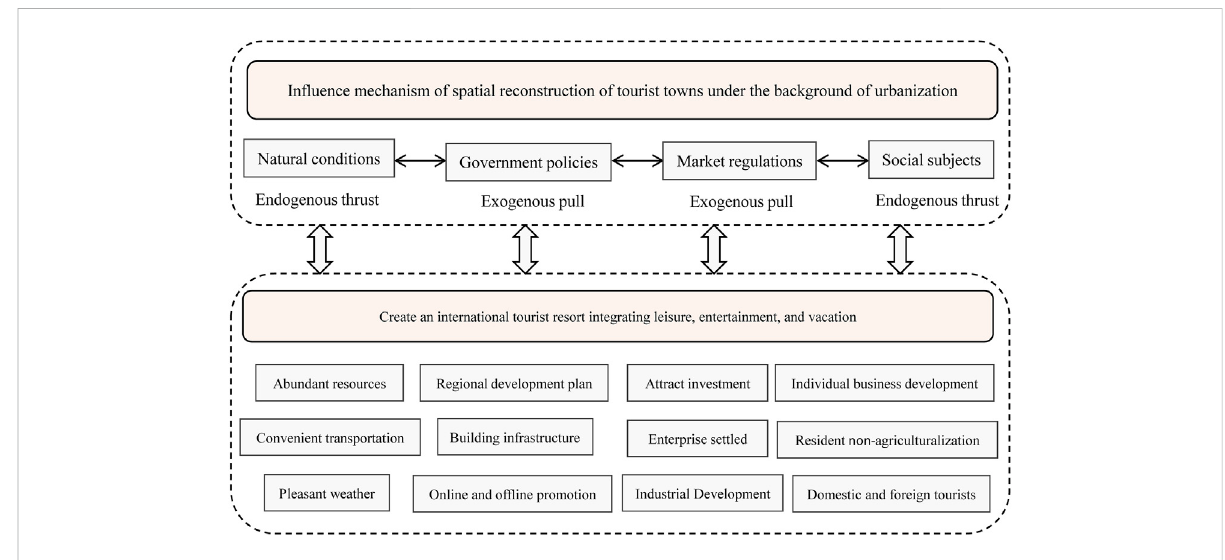
Drivers of the reconstruction of Jinshitan settlement